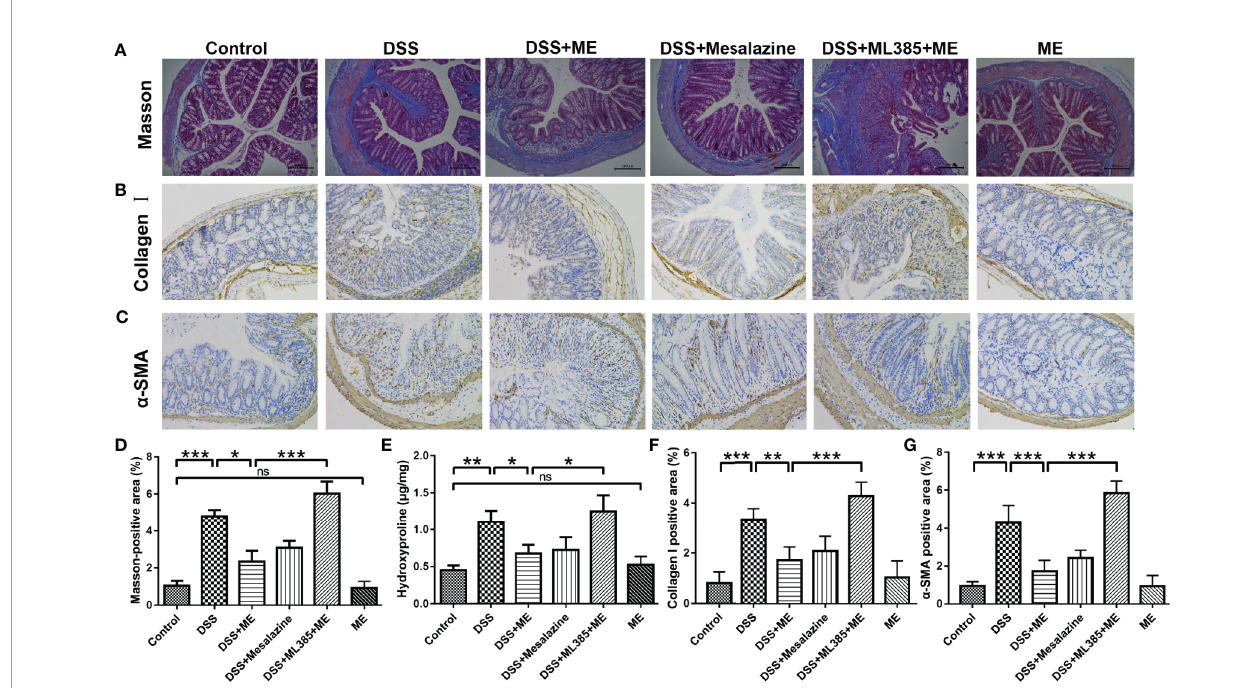
FIGURE 3 | ME inhibits the high levels of fi brosis markers in histological assays. (A) Representative image of the Masson trichrome-stained colon sections in the six groups: ECM deposition (blue area). (B) Representative immunohistochemical staining for a -SMA in colon sections and quantitative analysis. (C) Representative immunohistochemical staining for collagen I in colon sections and quantitative analysis. (D) Quantitative analysis of the masson-positive area. (E) Hydroxyproline assay of colon tissues from the mice in six different groups. Scale bar = 200 m m. (F) Quantitative analysis of the collagen I-positive area. (G) Quantitative analysis of the a -SMA-positive area. Data are presented as mean ± SD. ∗ P < 0.05, ∗∗ P < 0.01, and ∗∗∗ P < 0.001; ns, no signi fi